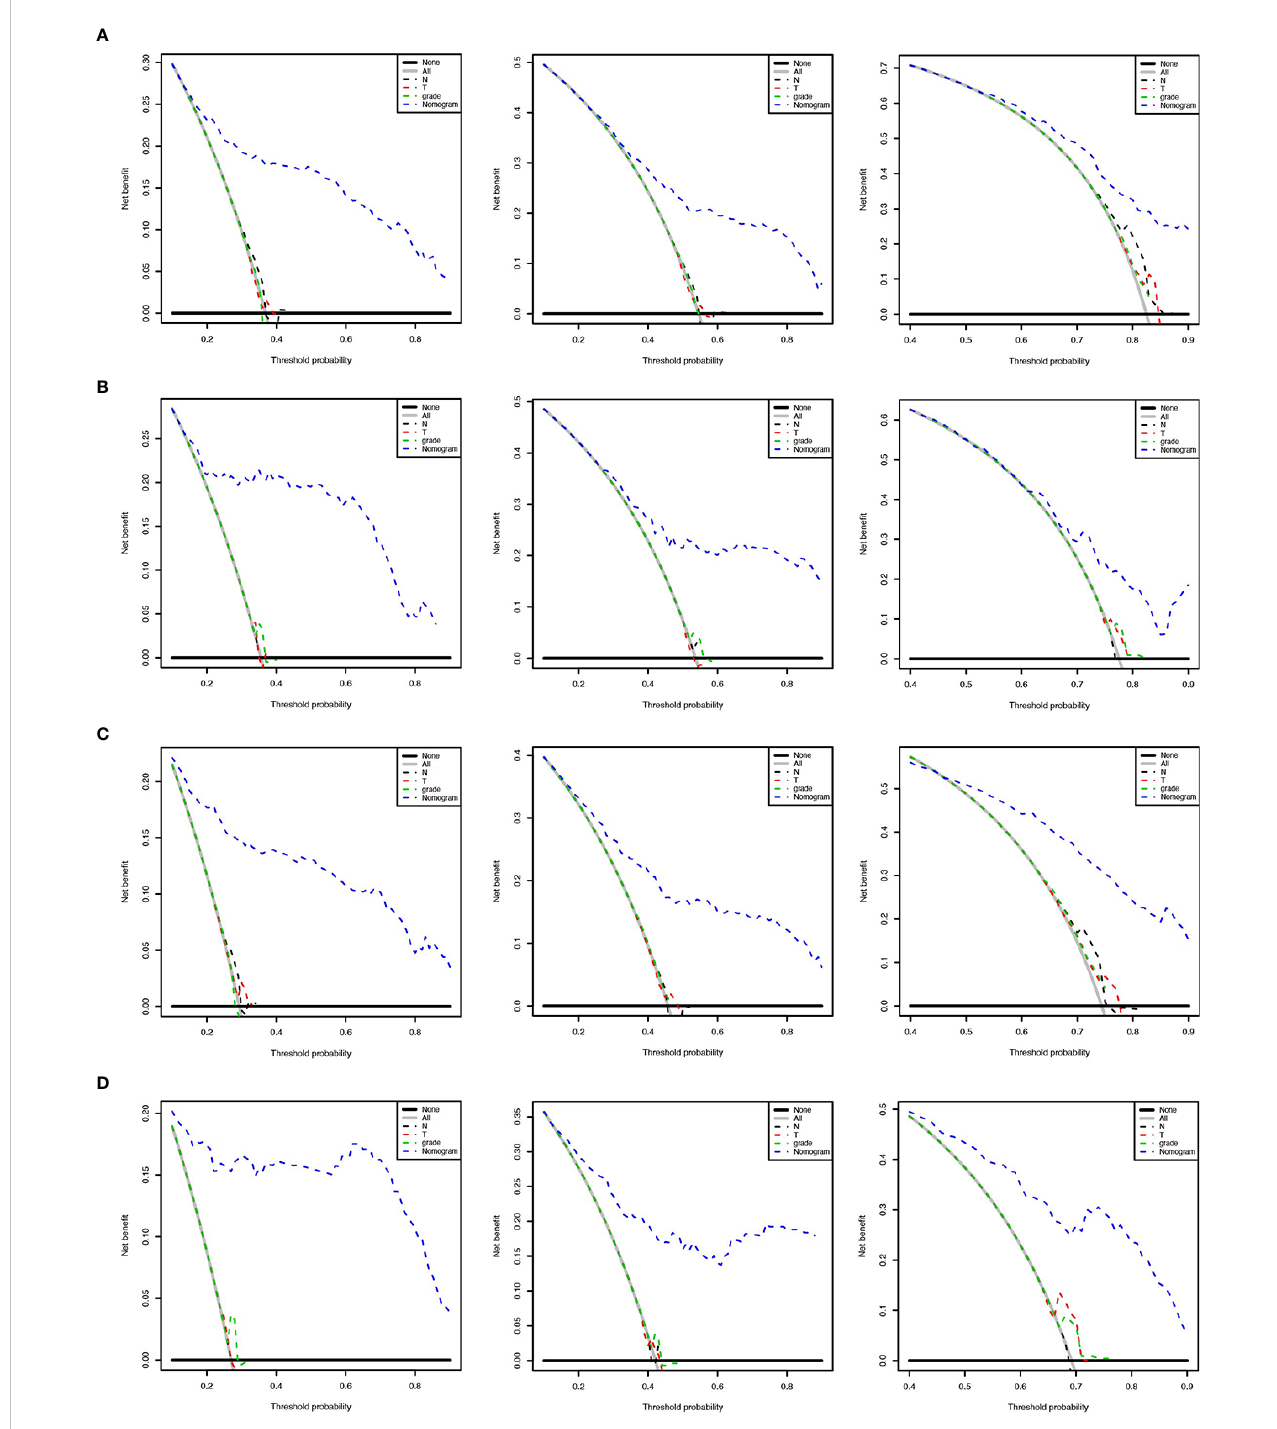
FIGURE 7 Decision curves to predict 3-month, 6-month and 12-month overall survival of SCLC patients with BM in the training cohort (A) and validation cohort (B) . Decision curves to predict cancer-speci fi c survival in SCLC patients with BM in the training cohort (C) and validation cohort (D)